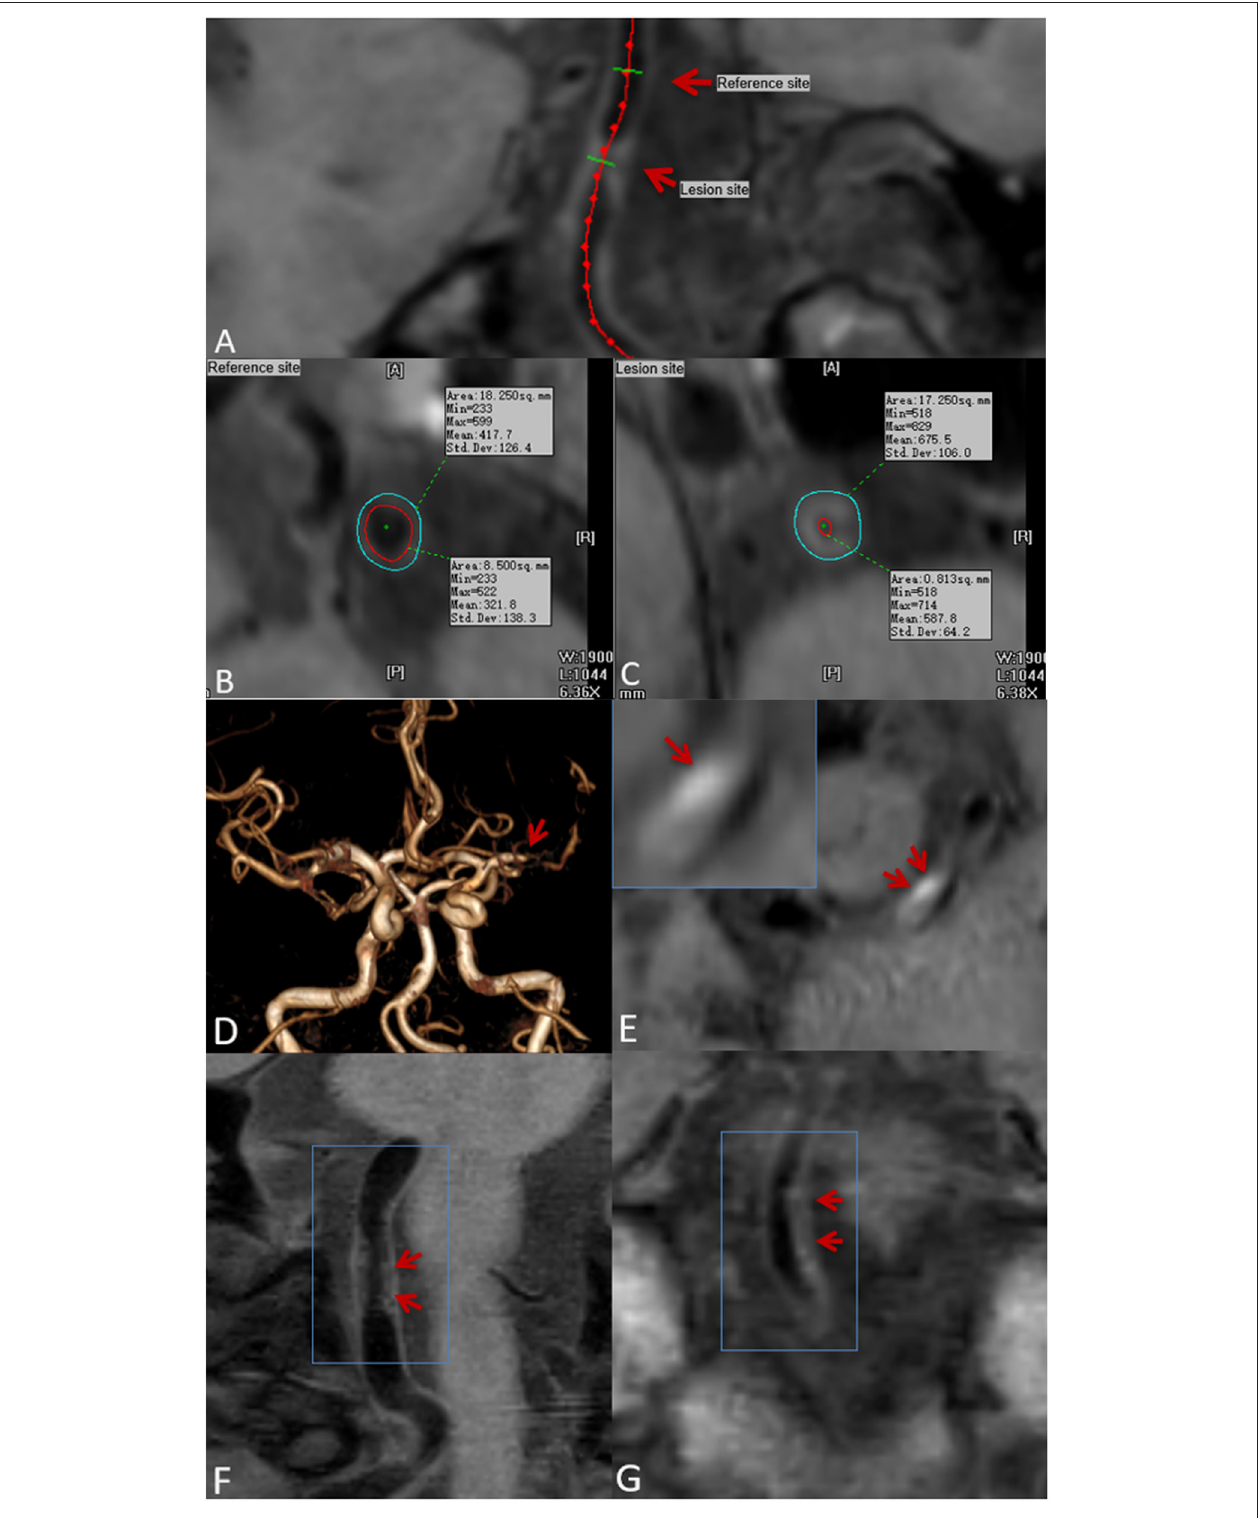
FIGURE 1 | Plaque localization, composition, and surface morphology recognition. Ts-imaging software was used to perform curved planar reconstruction for the vascular axis. (A) (red arrow) with the thinnest wall as the reference site (B) and the thickest cross-section of the plaque as the lesion site (C) . Lumen area (LA) and outer wall area (OWA) were calculated automatically by the software. Time-of-flight magnetic resonance angiography (TOF-MRA) showing stenosis of the M1 segment of the left middle cerebral artery (D) (red arrow): pre-contrast CMR vessel wall imaging shows an eccentric plaque at the stenosis, and a high-signal shadow can be seen in the plaque (E) (red arrow), indicating intraplaque hemorrhage. Plaque surface irregularity (F) , and regularity (G) (red arrow).